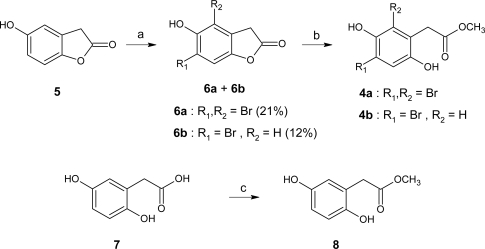
Synthesis of compound 4a.Reagents and conditions: (a) N-bromosuccinimide, p-toluenesulfonic acid, CH2Cl2, 12 h, rt; (b) ptoluenesulfonic acid, MeOH, rt, 24 h, 84% (4a), 78% (4b); (c) HClaq (1%), MeOH, rt, 24h, 97%.